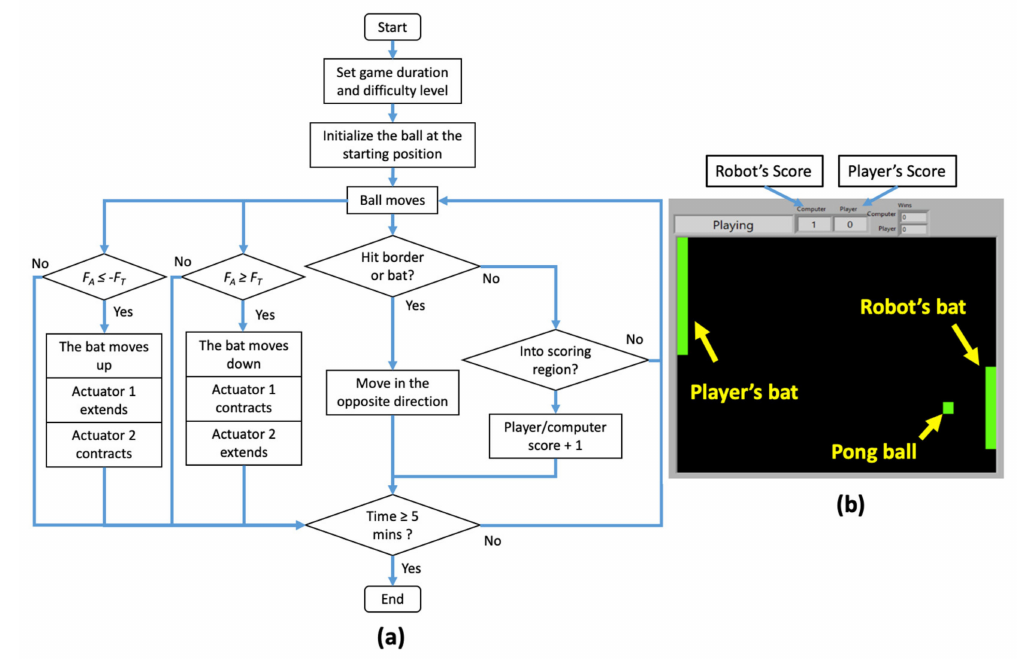
Figure 4. ( a ) The flowchart and ( b ) screenshot of the Pong